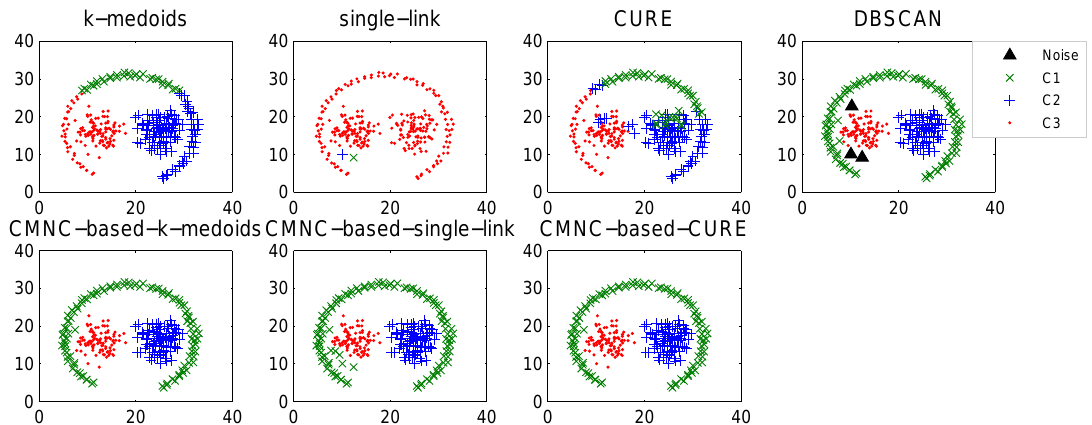
Figure 11. Comparison of clustering results on the “path-based” dataset.